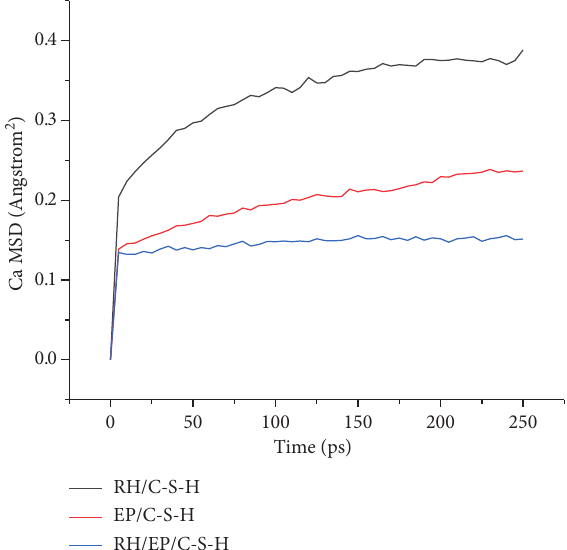
Figure 6: Mean square displacement of three models of Ca.